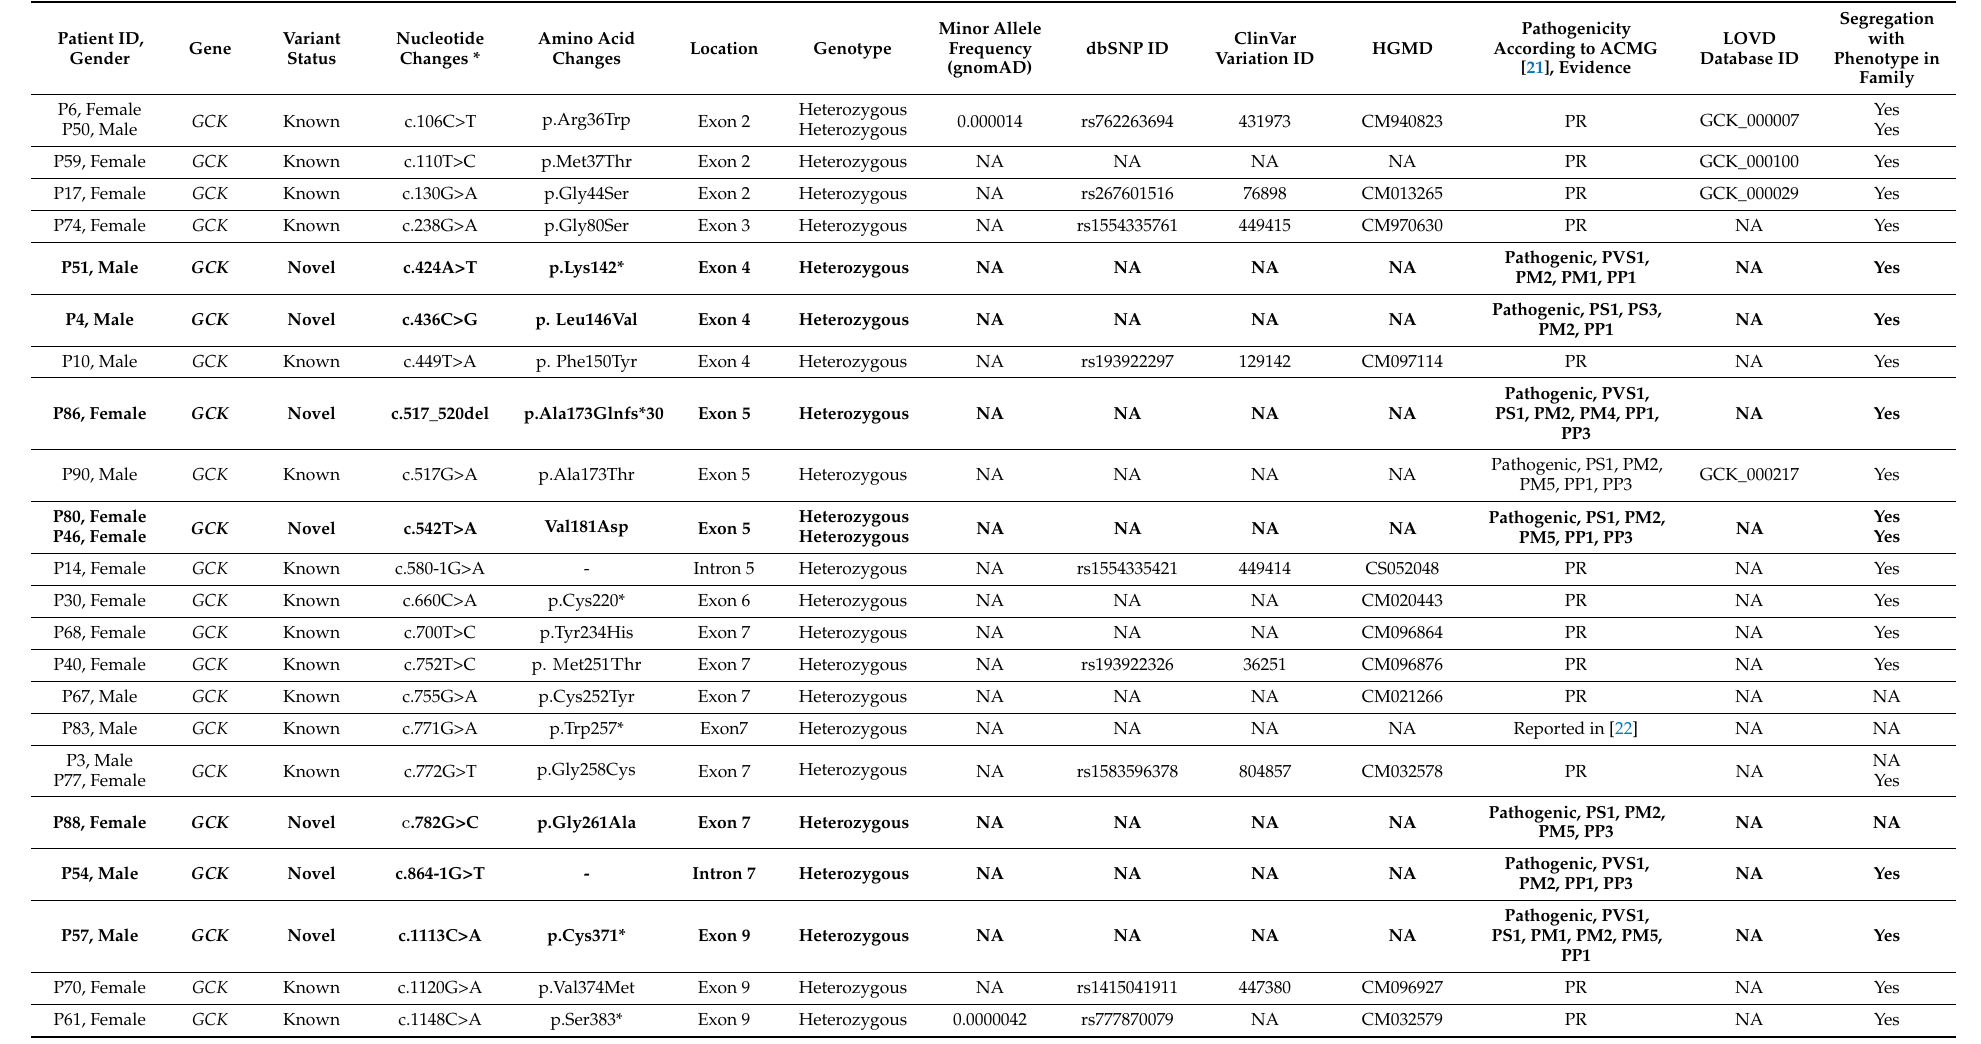
Table 2. The genetic variants identified in Western Siberia patients with a phenotype of maturity onset diabetes of the young